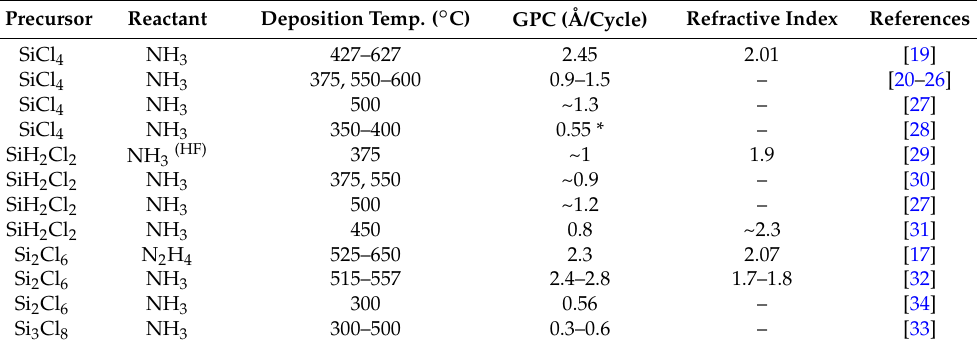
Table 1. Overview of silicon nitride thin films deposited by thermal